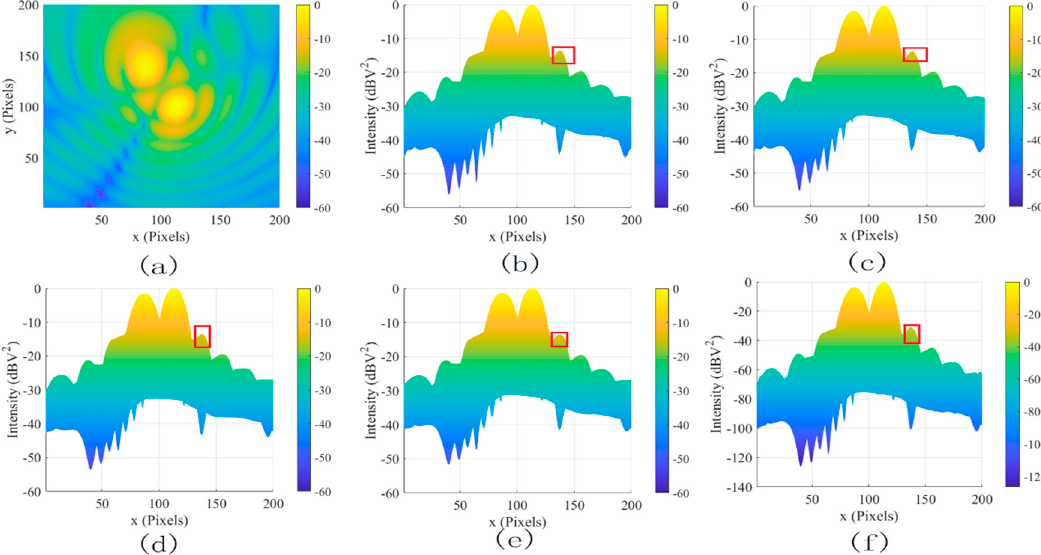
Figure 7. The filtered results for two dipole sources at 2 GHz. ( a ) The original image, ( b ) the lateral view of ( a ), ( c ) SDC, ( d ) MLG, ( e ) SAM, and ( f ) proposed.